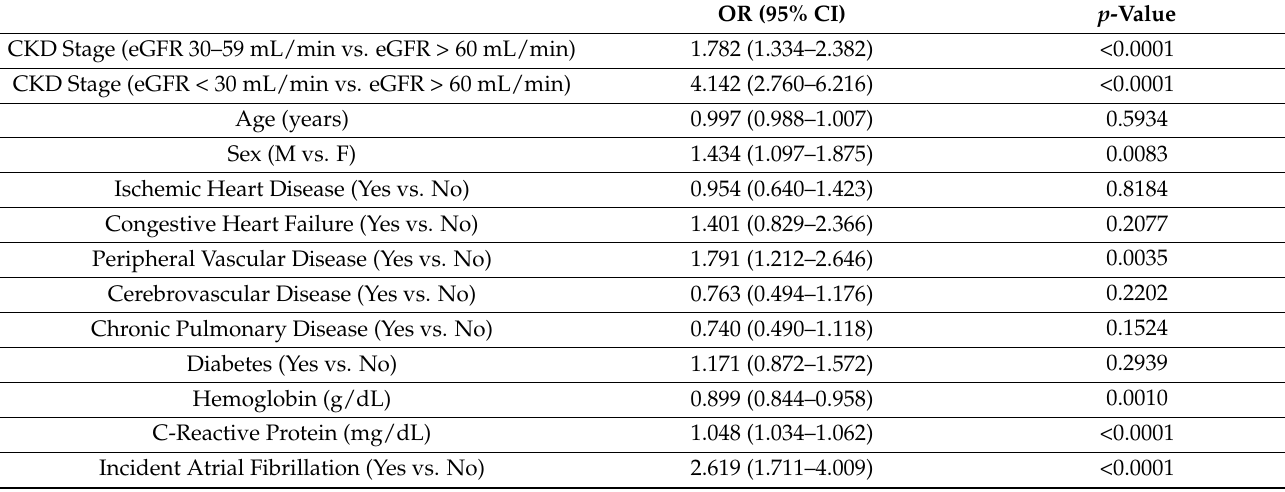
Table 5. Logistic model on the CKD effect on AKI during hospitalization adjusted by age, sex, comorbidities, incident AF, and relevant laboratory measurements. n = 2200, AKI =